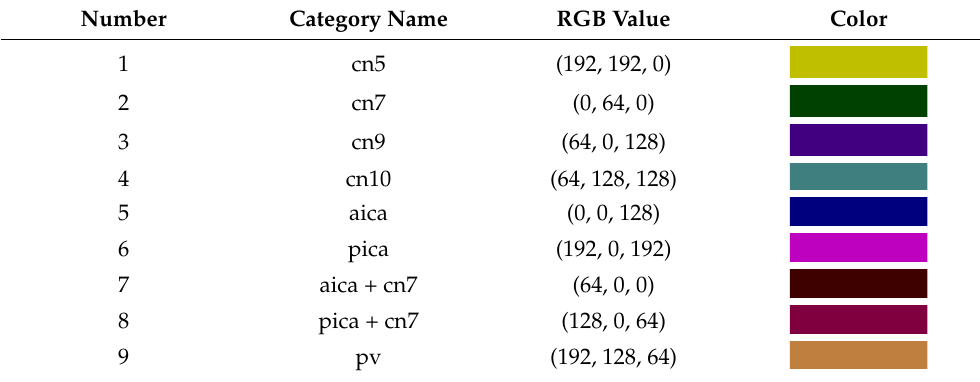
Table 1. Classification number, name, and color table.